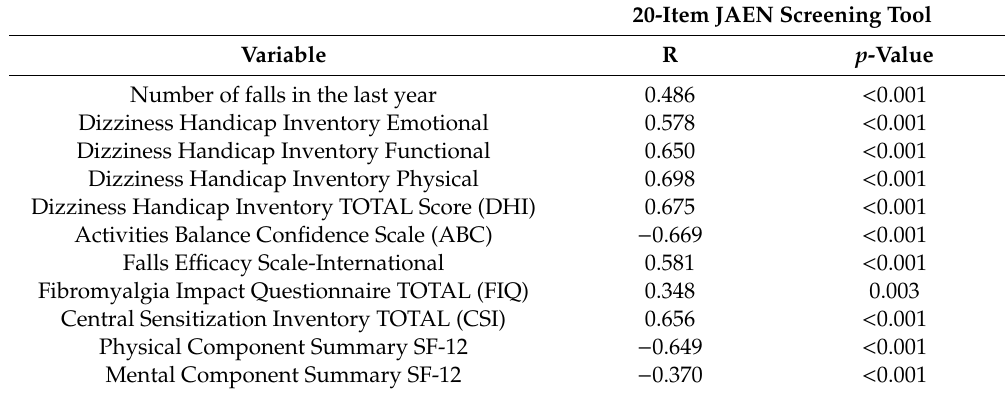
Table 5. Correlation between the 20-item JAEN screening tool and functional impact and balance scales.